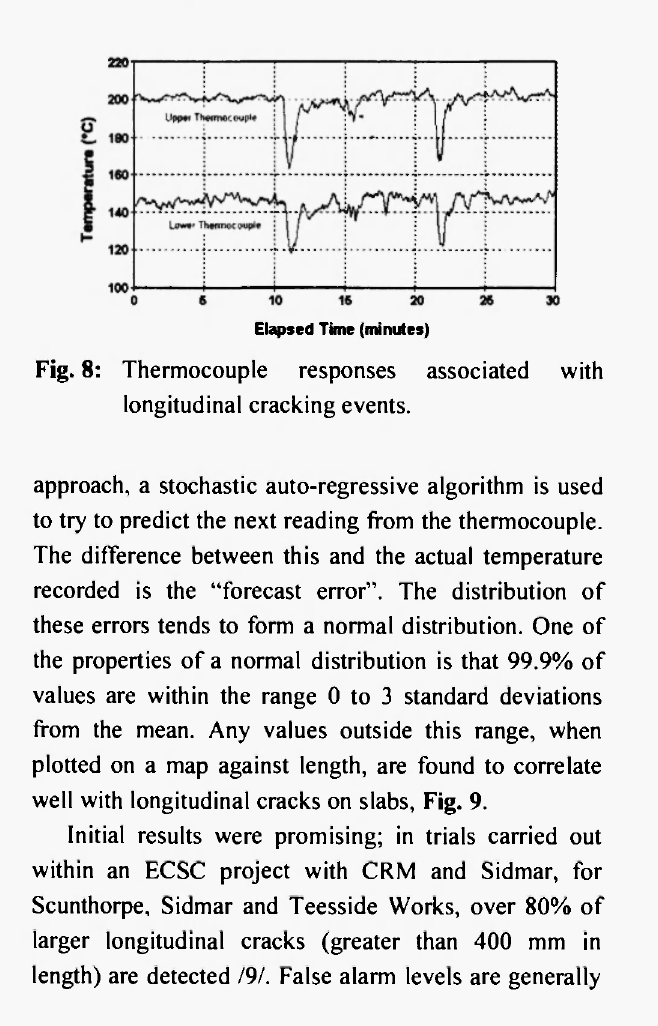
Fig. 7: Effect of carbon content on thermocouple temperature variability (Teesside).